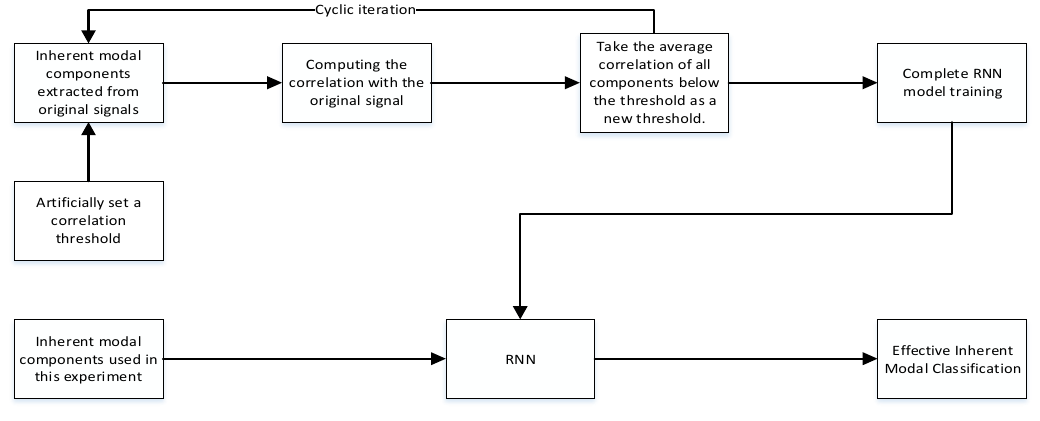
Figure 3. Long short term memory (LSTM) internal unit structure diagram.